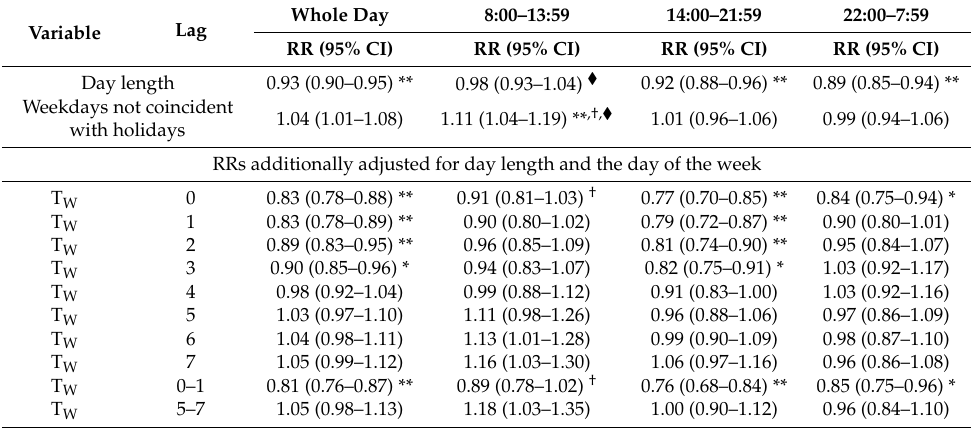
Table 2. Associations between day length, the day of the week, and air temperature above 1 ◦ C and emergency calls for elevated arterial blood pressure (EABP) in rate ratio (RR) per increase of 10 ◦ C for air temperature and 1 h for day length; adjusting for the month and years.